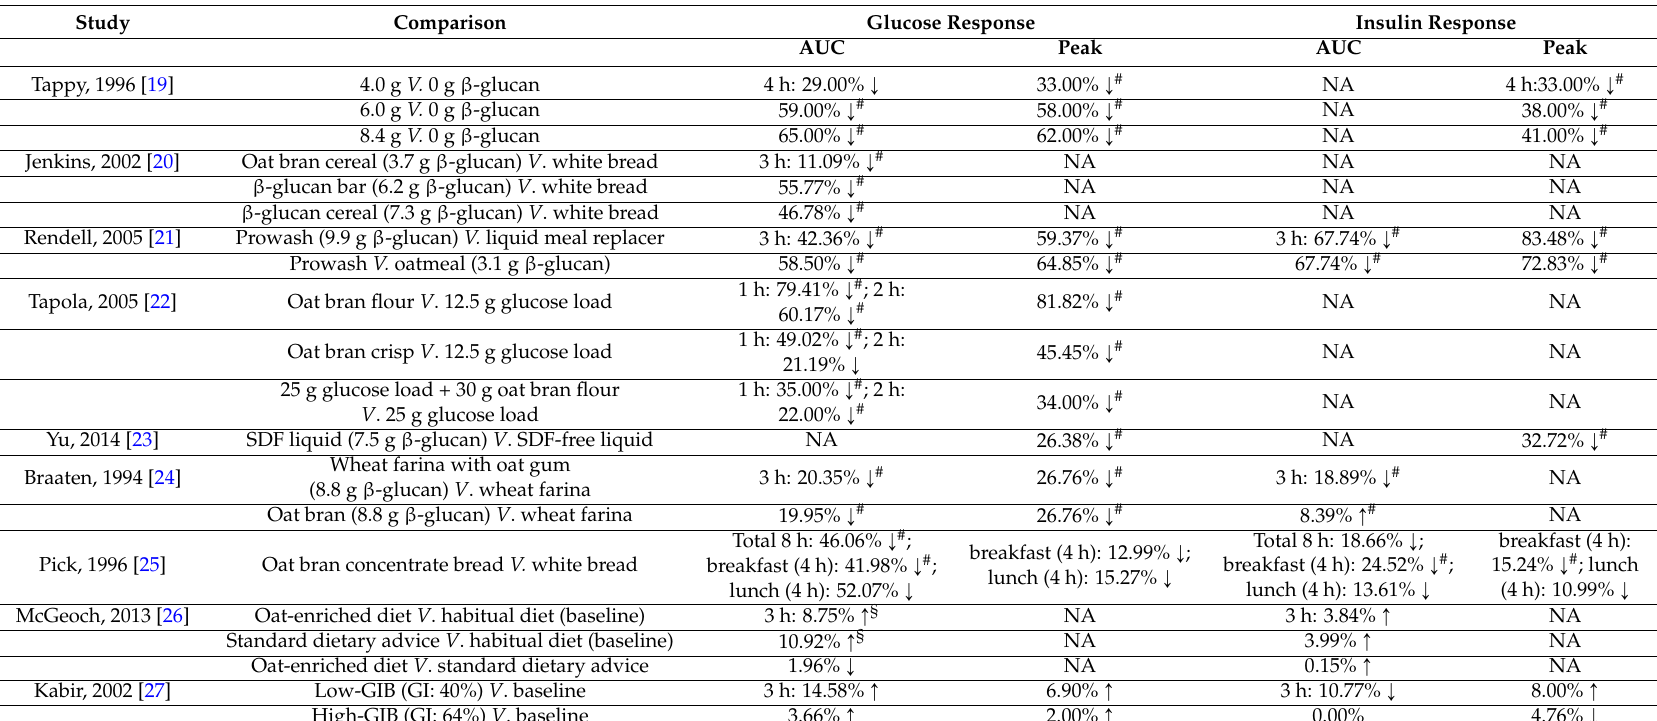
Table 4. Single meal responses of glucose and